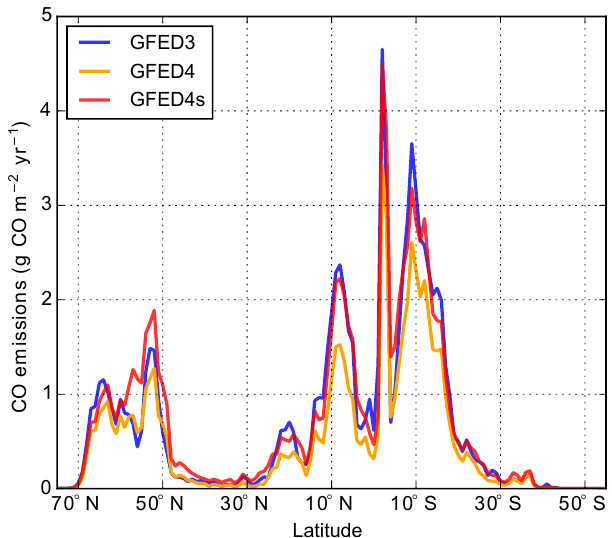
Figure 14. Latitudinal distribution of carbon monoxide (CO) emis- sions for GFED3, GFED4, and